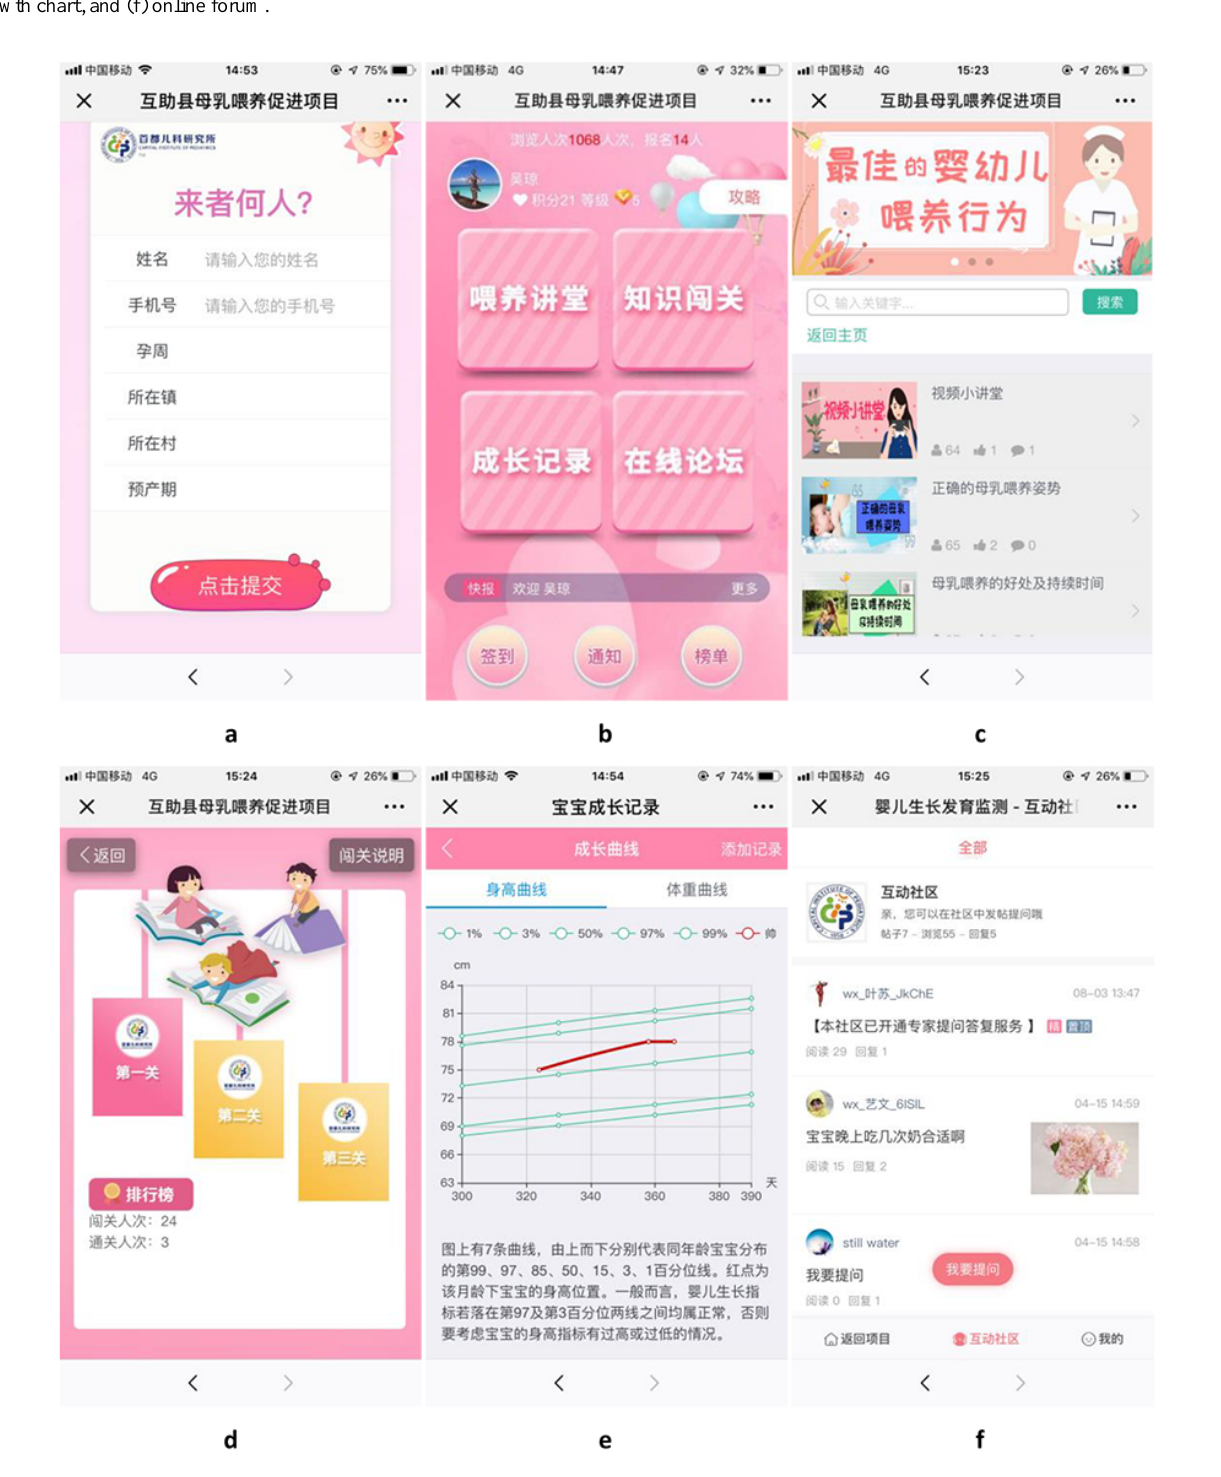
Figure 1. The interface of the WeChat intervention: (a) log-in interface, (b) main interface, (c) feeding messages, (d) feeding competition, (e) baby growth chart, and (f) online